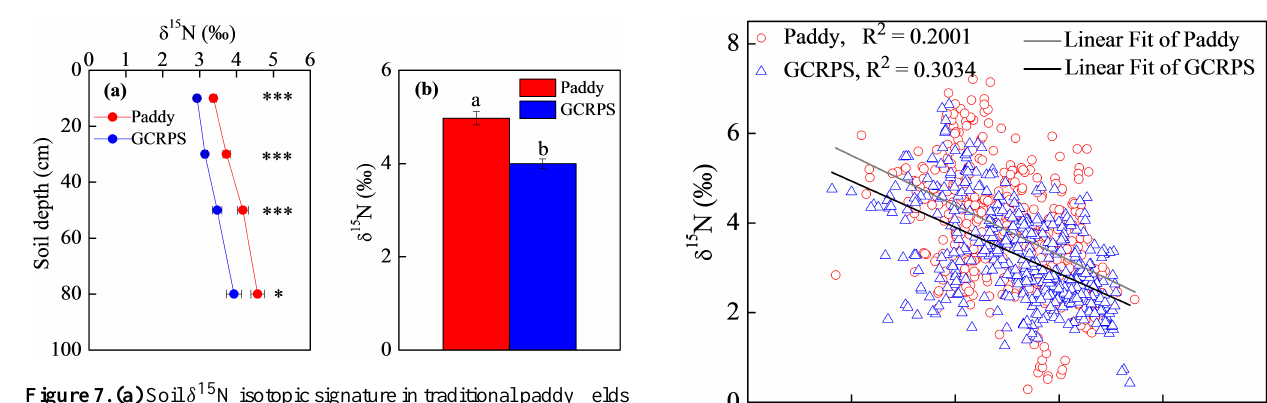
Figure 7. (a) Soil δ 15 N isotopic signature in traditional paddy fields and GCRPS at different soil depths. Data presented are the mean values pooled over 49 paired sites (for 0–20 and 20–40cm, n is 147; for 40–60cm, n is 108; and for 70–90cm, n is 63). (b) δ 15 N signature in plant leaves at maximum tillering stage. Data presented are the means pooled over 36 paired sites (these represent all the sites where rice was grown in 2011) with three replicates at each site; n is 108. Errors bars indicate the SEM. ∗∗∗ , ∗∗ , and ∗ denote significance at 0.001, 0.01, and 0.05 probability levels, respectively. Values that are not significant are denoted by ns . Bars labeled with different lowercase letters indicate differences ( P <0.05) between paddy fields and GCRPS.